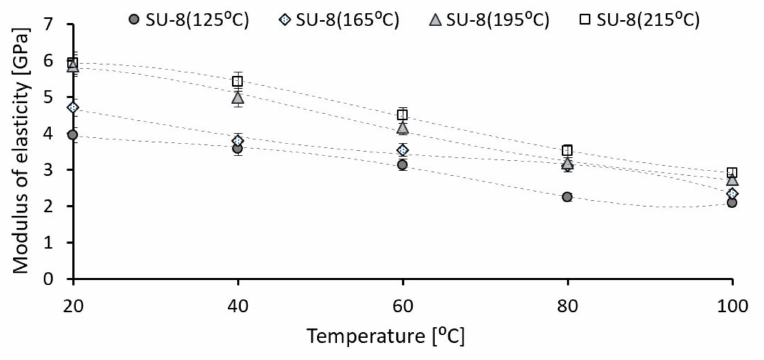
Figure 6. Testing temperature influence on modulus of elasticity of SU-8 hard baked at different temperatures (error amount percentage less to